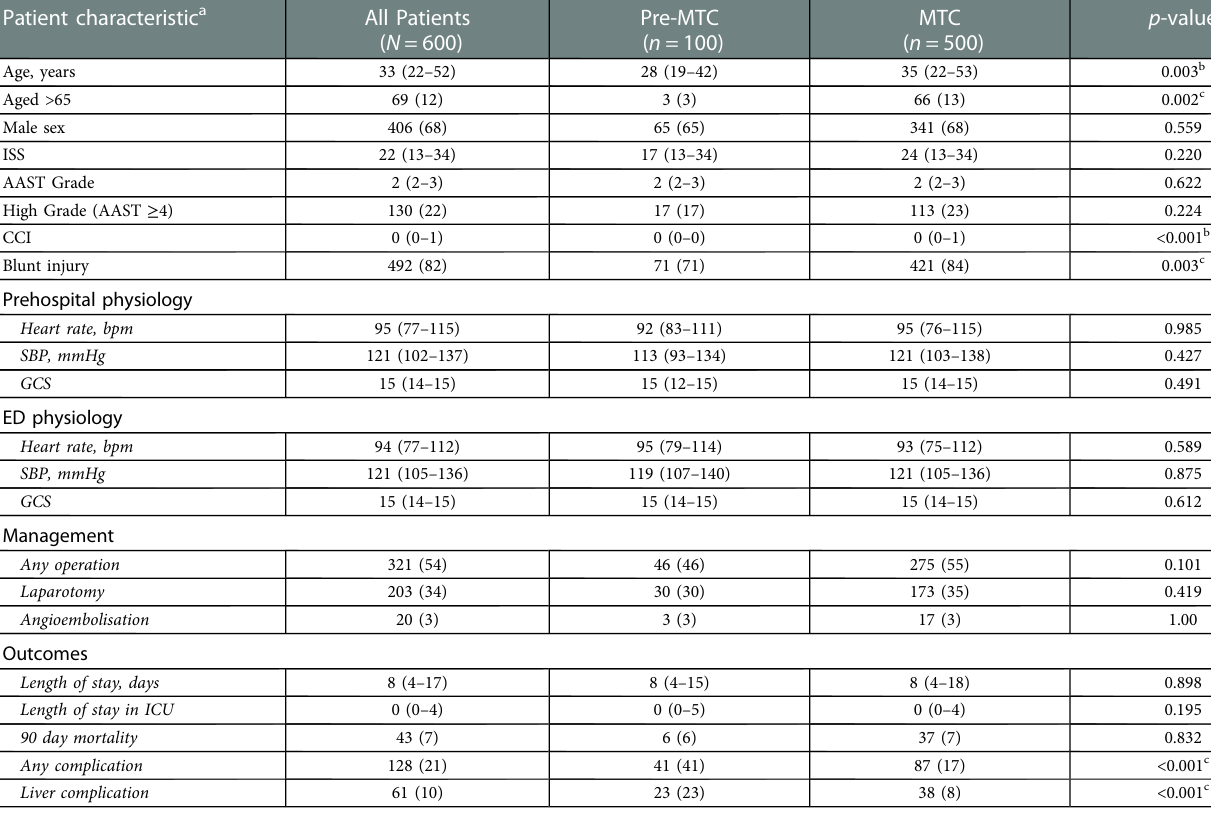
TABLE 1 Patient characteristics compared between those pre- and post- MTC status in 2012. Patient characteristic